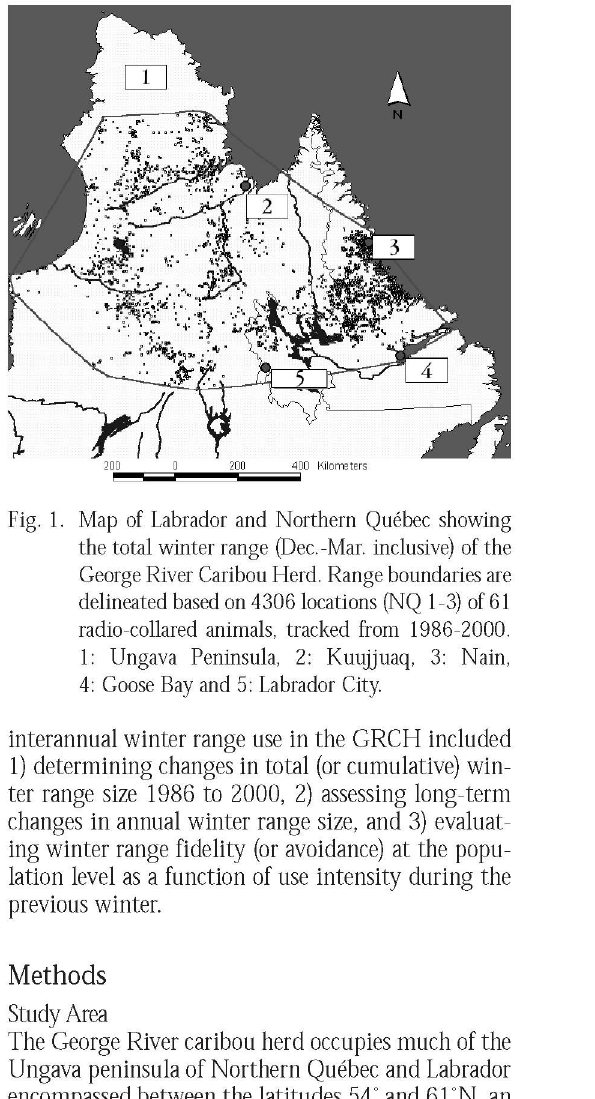
Fig. 1. Map of Labrador and Northern Québec showing the total winter range (Dec.-Mar. inclusive) of the George River Caribou Herd. Range boundaries are delineated based on 4306 locations (NQ 1-3) of 61 radio-collared animals, tracked from 1986-2000. 1: Ungava Peninsula, 2: Kuujjuaq, 3: